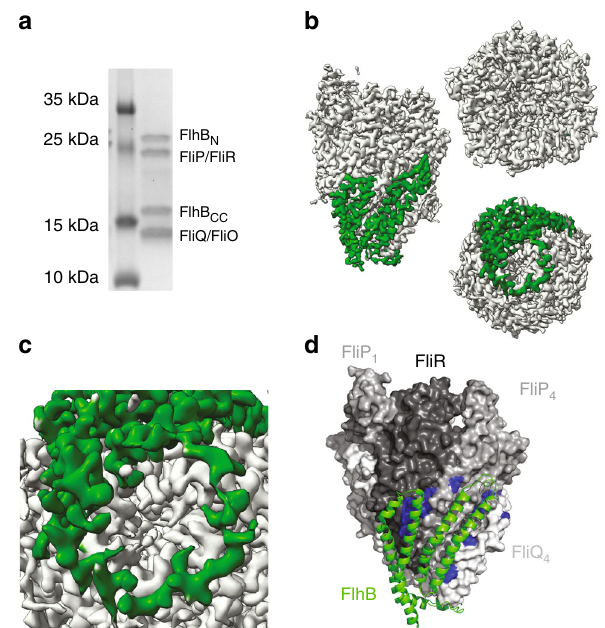
Fig. 2 Architecture of the FliPQR – FlhB export gate complex. a SDS-PAGE gel of the V. mimicus FliPQR – FlhB complex. b Cryo-EM density map of the FliPQR – FlhB complex with the density corresponding to FlhB coloured in green. c Zoom of the FlhB loop at the bottom of the complex. d Model of FliPQR (surface) and FlhB (cartoon, green) with residues in FliP/SctR and FliR/SctT crosslinking to FlhB/SctU highlighted in blue as in Fig.